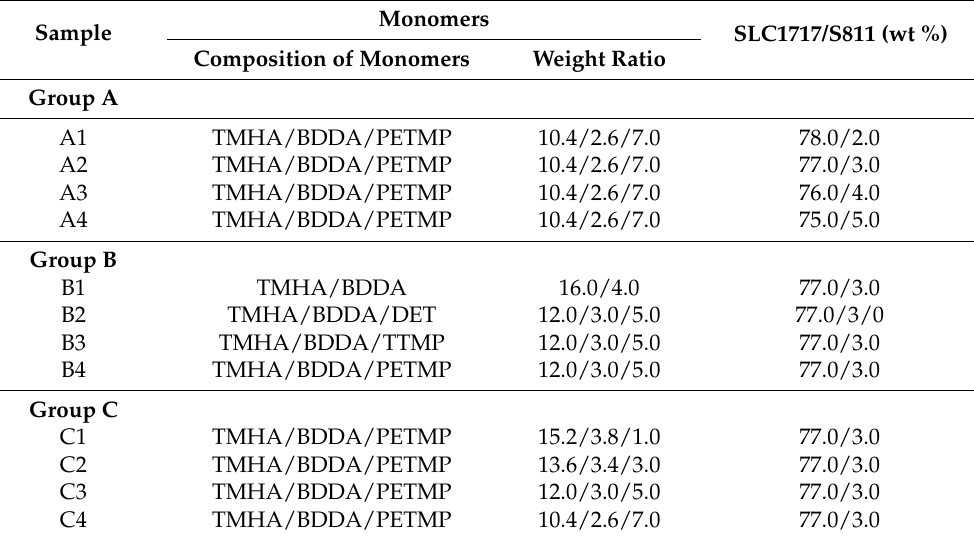
Table 1. The compositions of all the